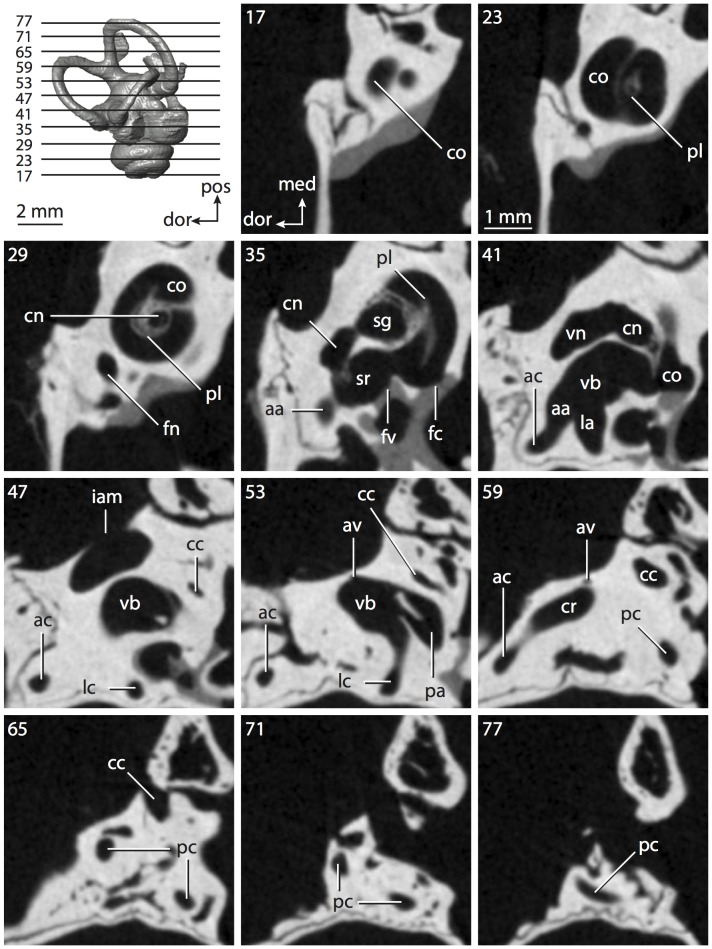
CT slices through ear region ofManis tricuspis.Abbreviations listed at the end of the Materials and Methods section.